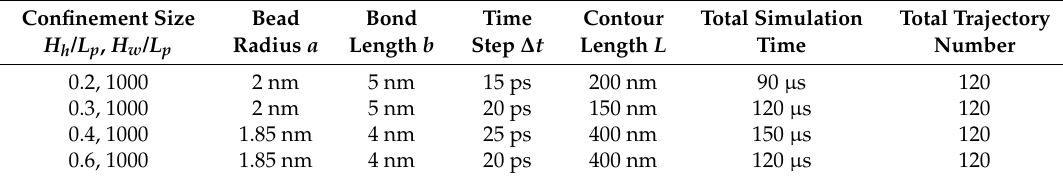
Table 5. Simulation parameters for the confinement of slits